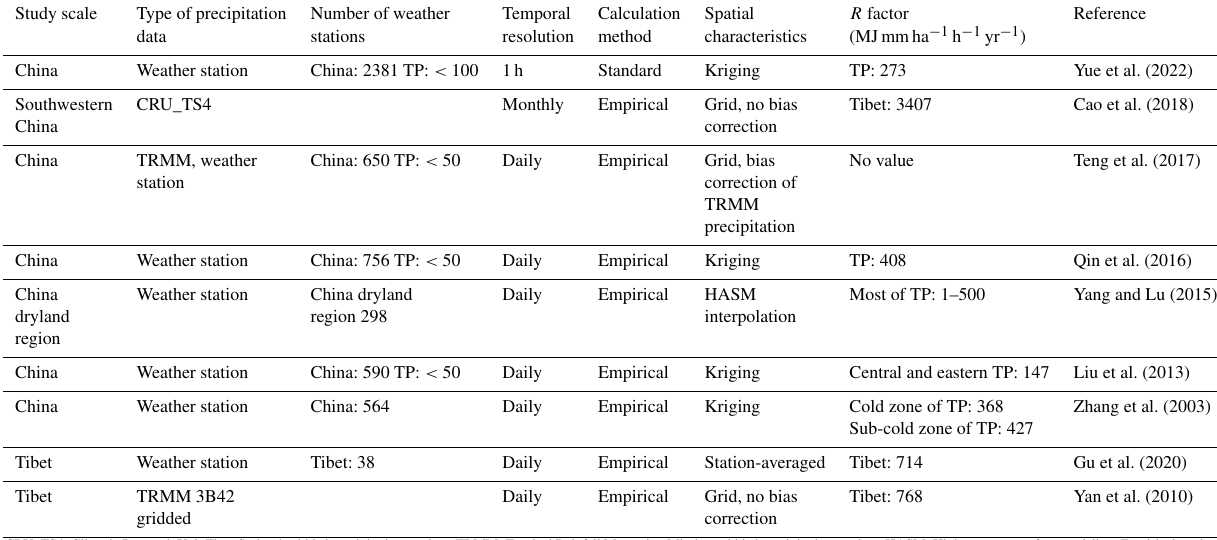
Table 1. R factor of TP in previous studies. Study